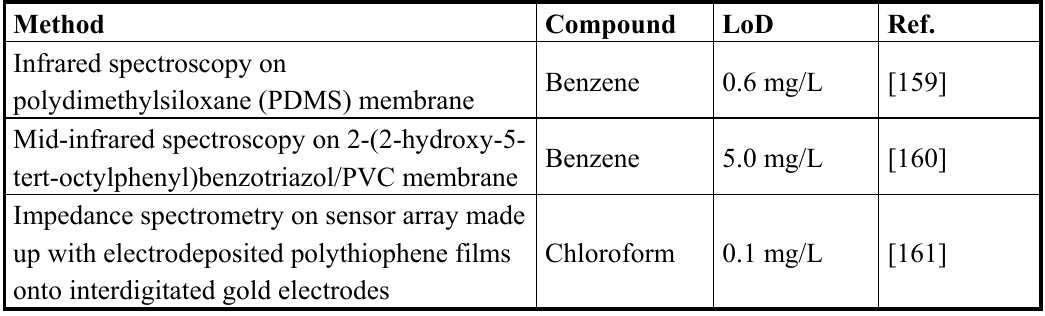
Table 13. Micro-sensors for solvent determination in